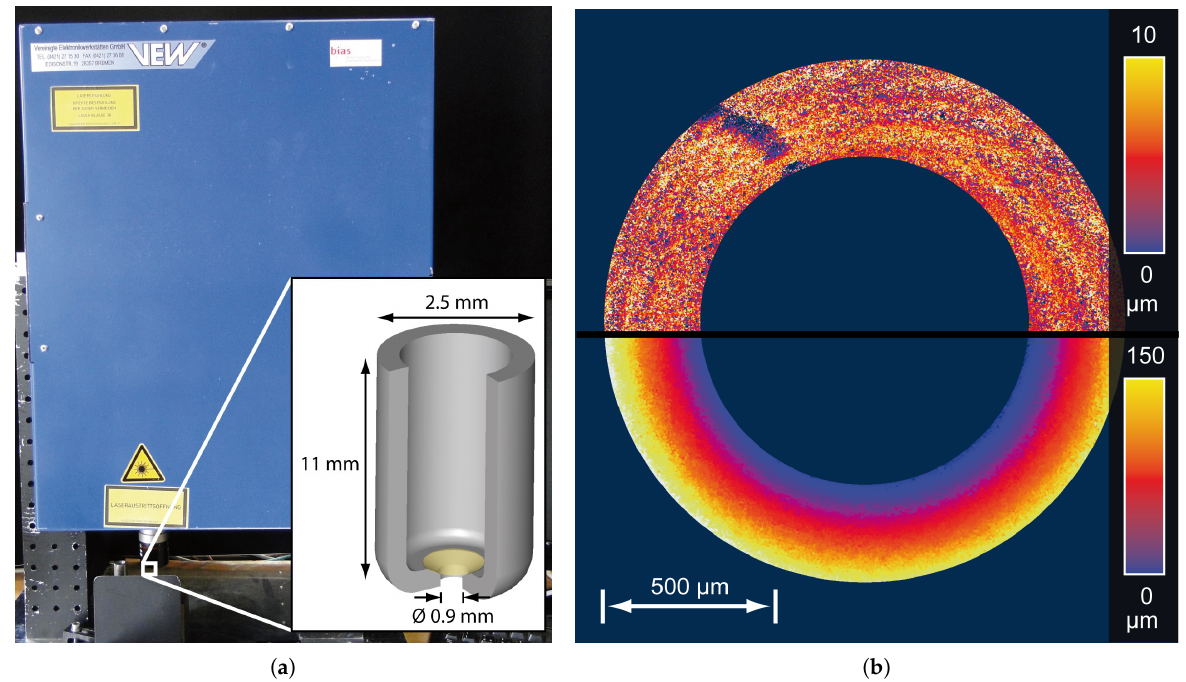
Figure 4. Digital holographic microscopy inside of cavities: ( a ) Digital holographic microscope, which is capable of testing one part per second. The inset shows a sketch of a typical object the system is designed for. The highlighted surface inside the cylinder is the region of interest. ( b ) A composed image of the same measurement result. The lower half depicts the measured profile, while the upper half shows the deviation from the known shape. We can clearly see a groove with a depth of approximately 5 µ m, which indicates that this part is